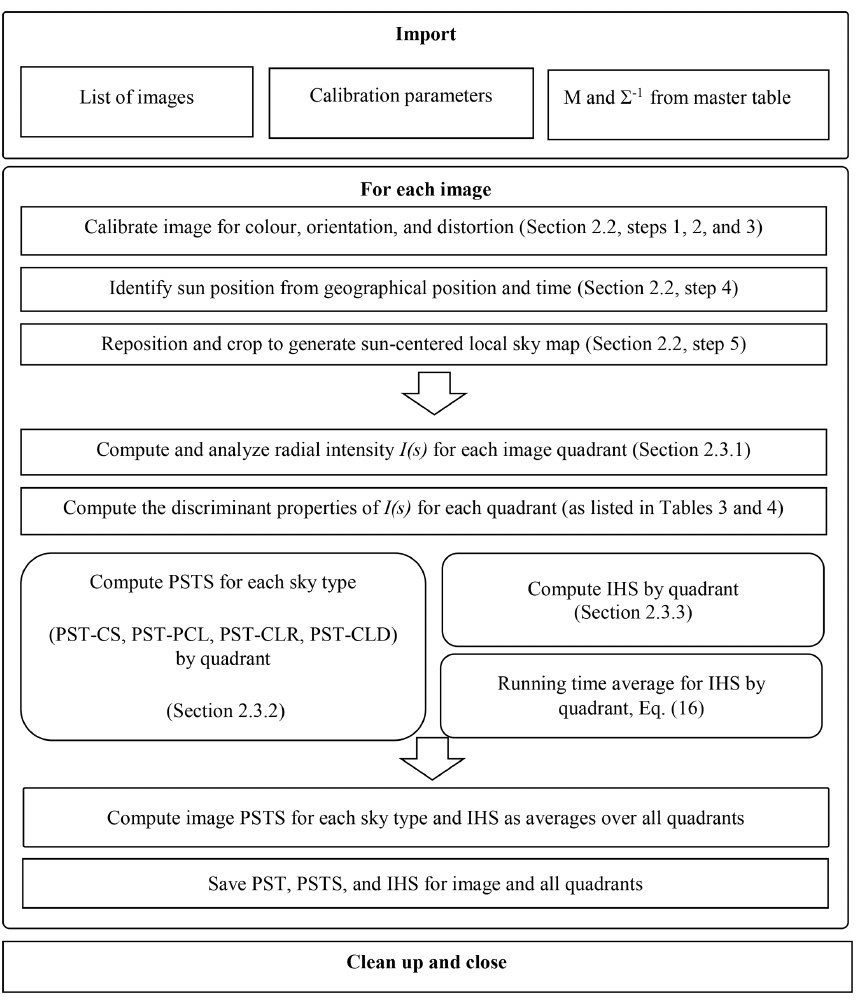
Figure 1. Flow chart of the algorithm for the analysis of TSI images.